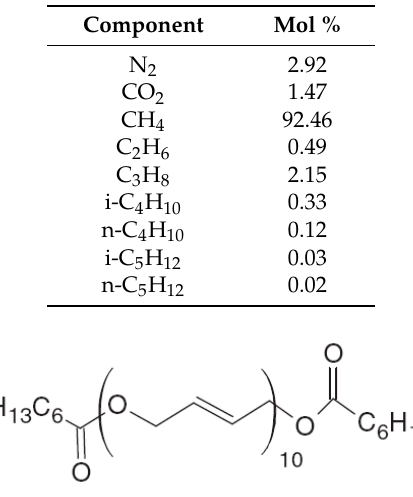
Table 6. Composition of Natural Gas Used to Form Hydrates.